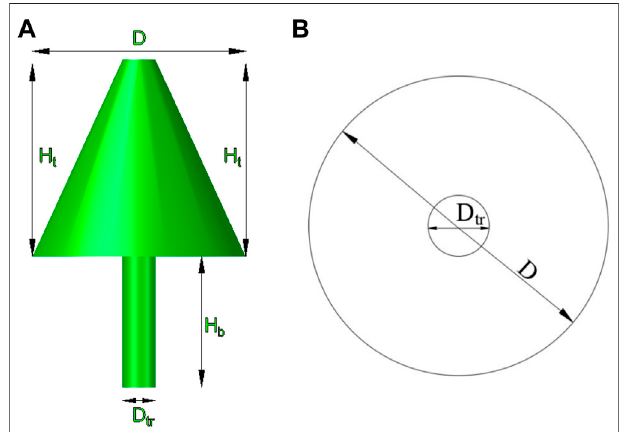
FIGURE 1 | Simpli fi ed schematic diagram of plant. (A) : The size of plant, (B) : Trunk diameter.